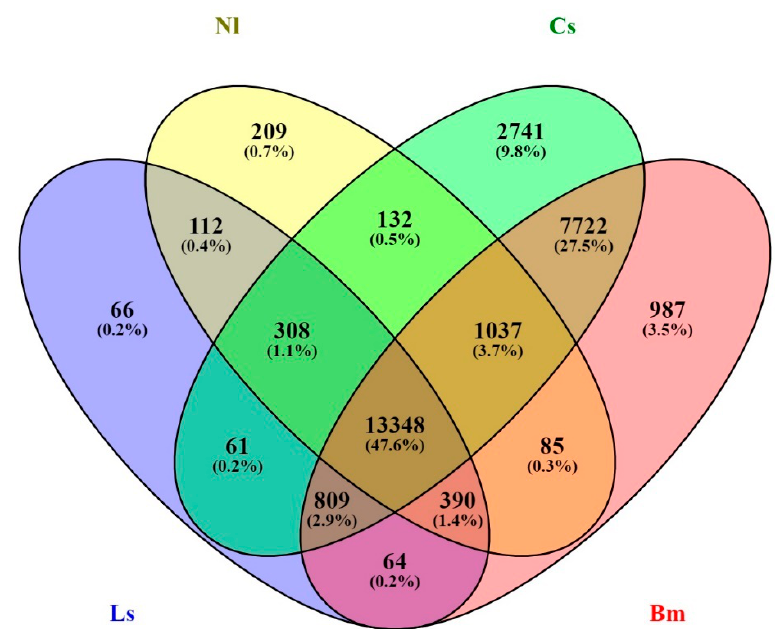
Figure 3. Venn diagram depicting the relation between four different insect species. The Venn diagram shows the common and unique genes of N. lugens, C. suppressalis, L striatellus , and B. mori shared with